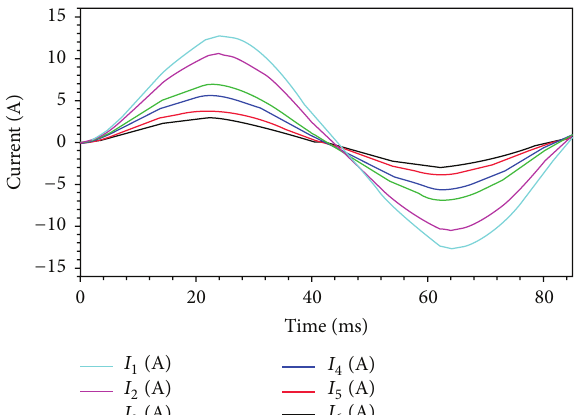
Figure 18: Position and velocity of the translator.